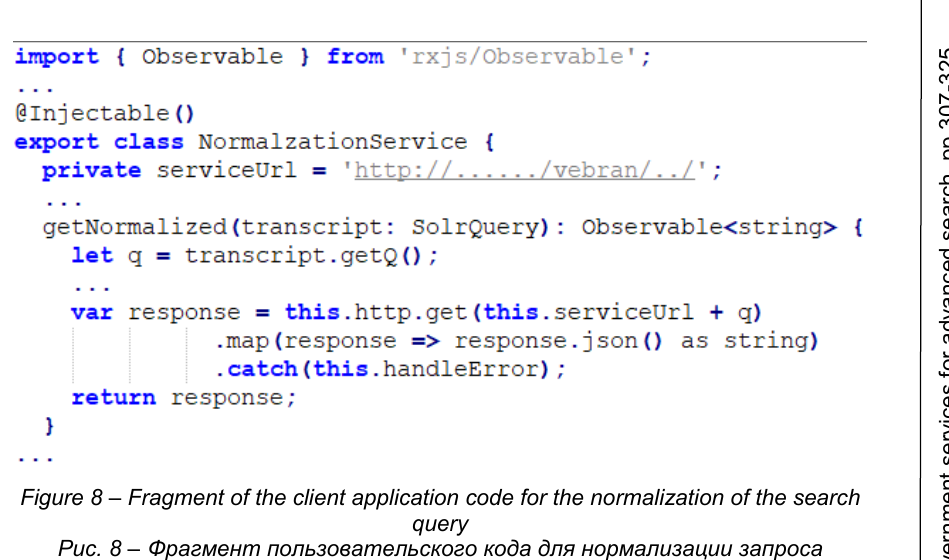
Figure 8 – Fragment of the client application code for the normalization of the search query Рис . 8 – Фрагмент пользовательского кода для нормализации запроса Слика 8 – Фрагмент клијентског кода за нормализацију упита